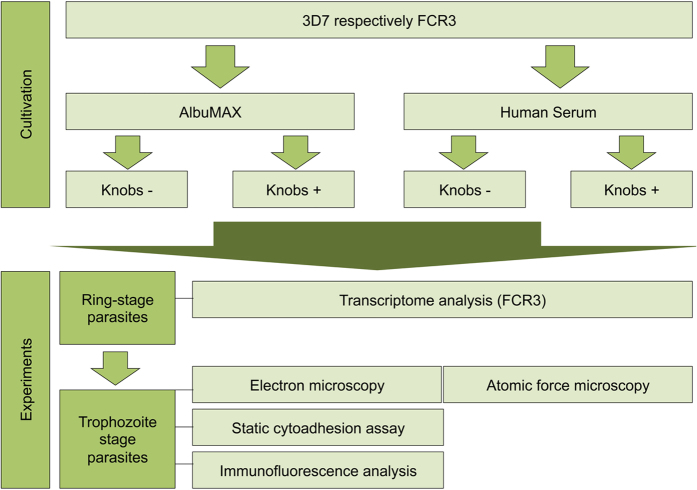
Flow chart summarizing the procedure of the comparative study of isolates 3D7 and FCR3 cultivated under different conditions.